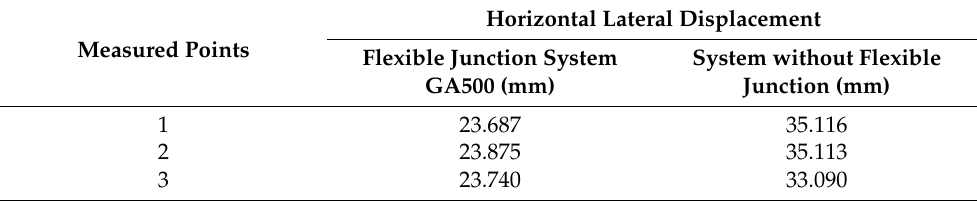
Figure 10. The value of the displacements in the most loaded section model CA500, 250 N, by MEF-without a flexible junction. Table 6. The lateral junction system GA500 vs. system with flexible junction, 250 N.